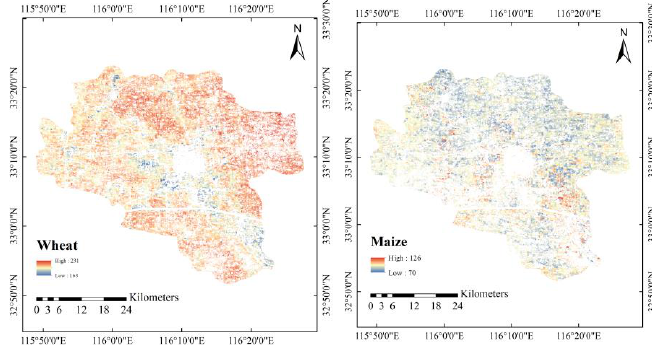
Figure 14. Spatial distribution of the crop growing season.